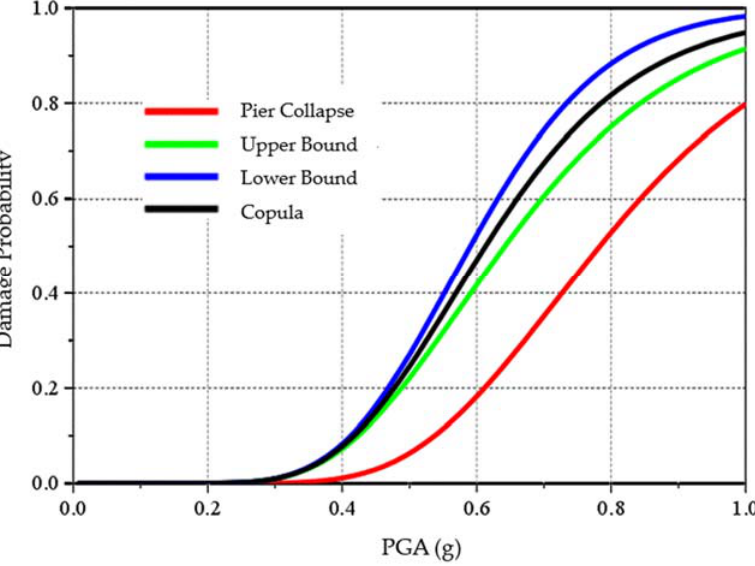
Figure 8. The seismic fragility curve of the overall bridge based on the copula function method.